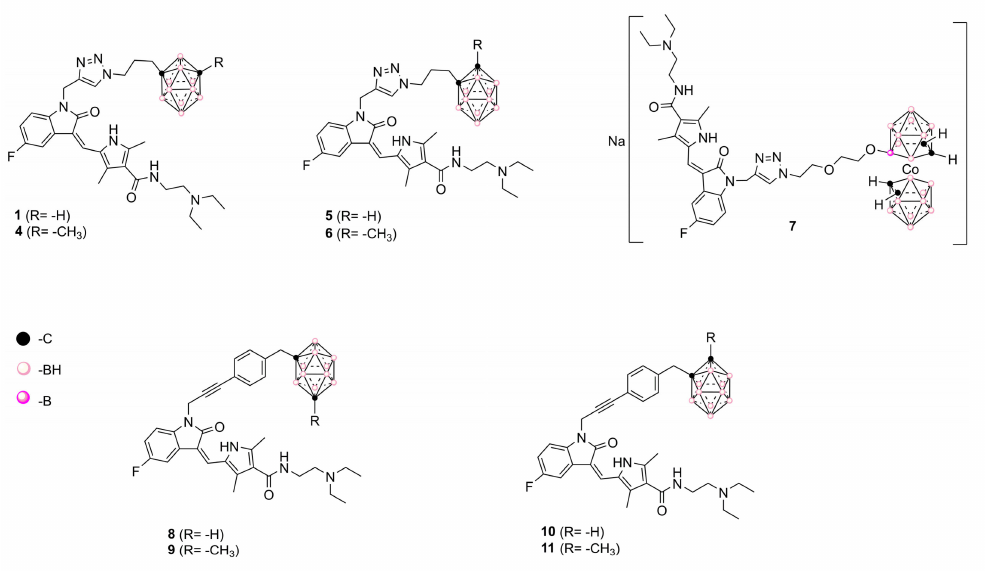
Figure 2. Representation of Sun -icosahedral boron cluster hybrids [22]. Table 1. In vitro activity of the most relevant hybrid TKI–boron clusters and the corresponding parent compounds against di ff erent TKR-overexpressing tumor cells, U87 MG, C6, and HT-29.